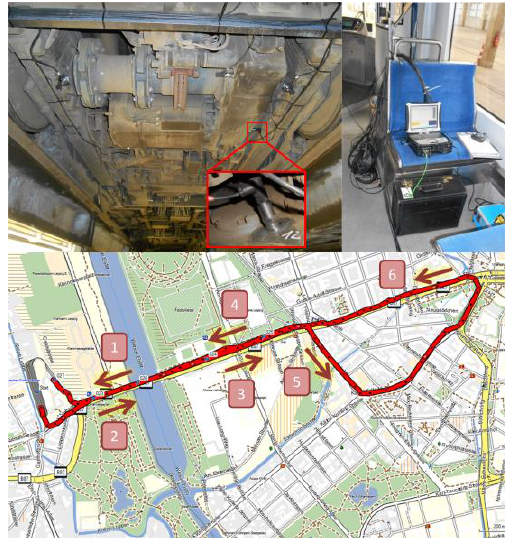
Figure 2. Comparative investigations with cable-bound measurement technology [6]. The upper figure shows the installation conditions of the sensors.